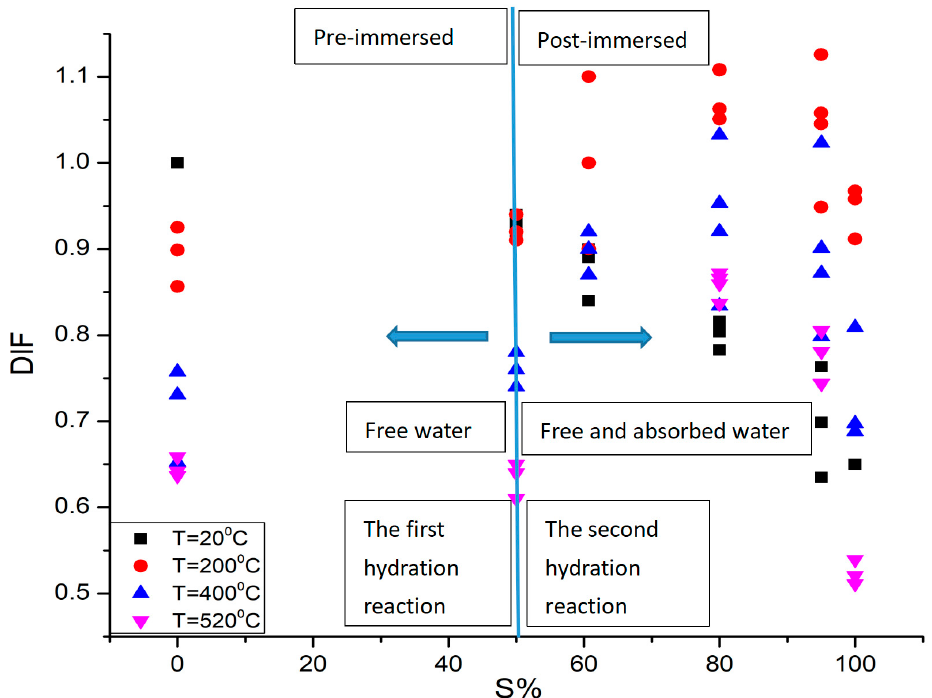
Figure 8. Relationship between the heat–moisture combined effect factor DIF and the relative saturation ratio S of the specimens for the compressive strength of the immersed concrete specimens.